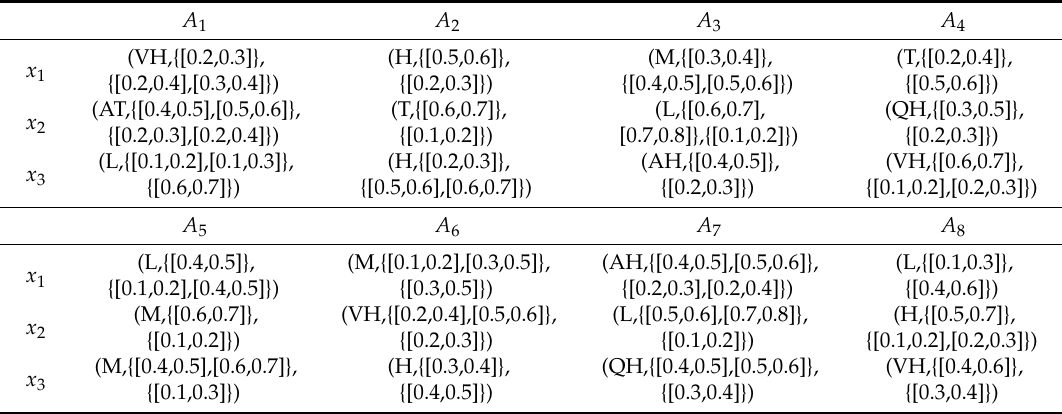
Table 2. The IVDHFUBL decision matrix R 1 provided by decision-maker E 1 .